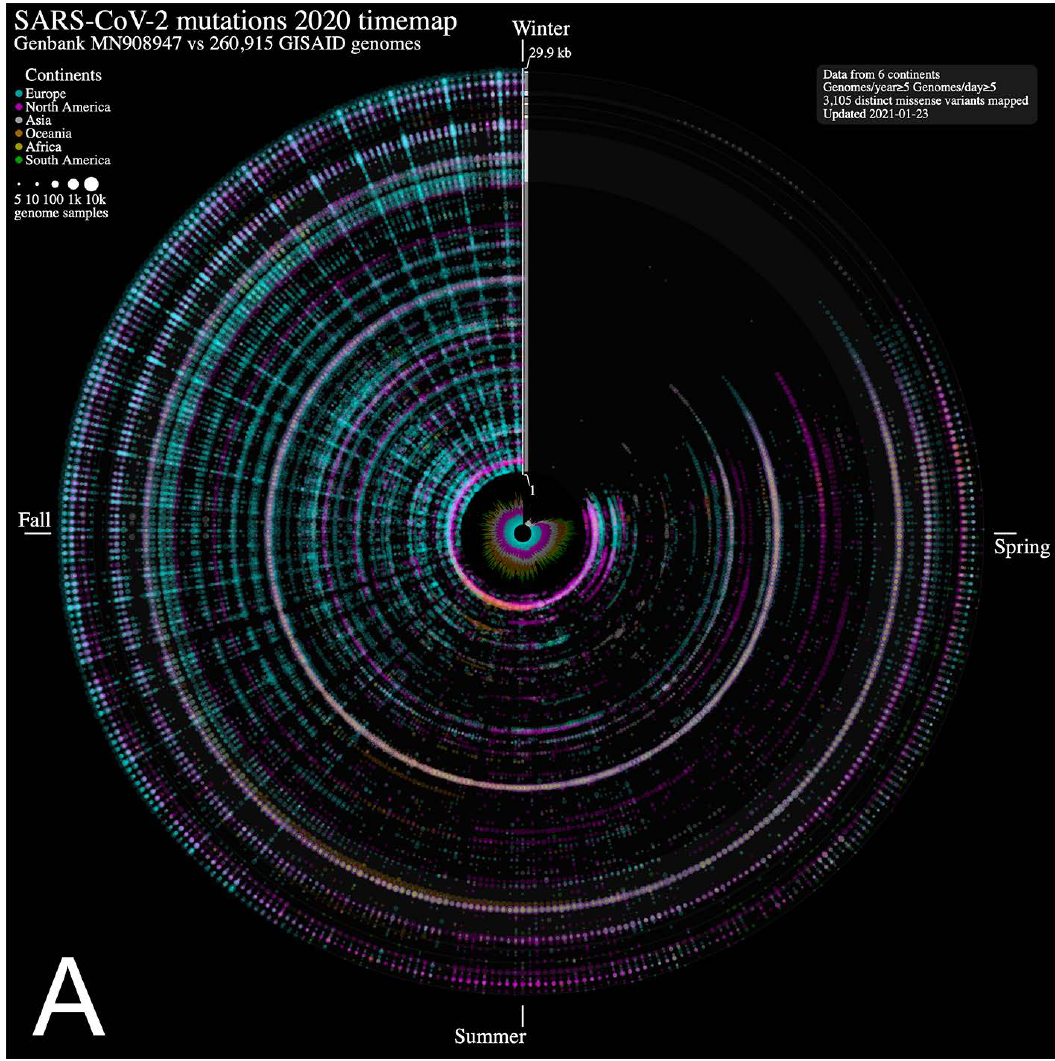
Figure 1. Severe acute respiratory syndrome coronavirus 2 (SARS-CoV-2) evolution in human hosts. ntEdit was used to map nucleotide variations between the first published coronavirus isolate from Wuhan, China in early Januaryandover260,000SARS-CoV-2genomessampledfromaroundtheglobeduringthe2020coronavirusdisease 2019 (COVID-19) pandemic. The maps show missense mutations arising daily (A) in the world within the whole viral genome, with the reference genome represented by the vertical axis from bases 1 to 29.9 kbp and (B) in Europe within the spike protein gene. Alternating dark / light grey vertical rectangles and associated tracks depict, starting from the center, SARS-CoV-2 genes ORF 1 AB , S, ORF3 A , E, M, ORF6, ORF7 A , ORF8, N, and ORF10. Mutations identified daily are represented by circles in a given radius and are coloured by regions and sized relative to raw count (panel A) or ratio (panel B) of the daily samples. A stacked bar plot (center) shows sample count. The 2020 calendar year mutations are organized clockwise from the upper vertical. Hovering the mouse cursor over each data point reveals additional insights about the mutation, and each map offers a navigation wheel allowing to pan inall direction and zoomin/out(panelB).PanelBshowsanannotatedtimemapofEurope,highlightingthedetectionofthefirstD614G spike protein gene mutation on January 28 th 2020 (Germany, n = 3, upper right). We also highlight the N501Y spike mutation first observed on September 20 th 2020 (panel B, inset) in only 1.7% (n = 2) of the Wales, UK daily genome samples, and at the end of the year on December 28 th 2020 in 15.5% (n = 13) of the daily collected Wales, UK samples (data updated on May 24 th , 2021). White arrows near the genome axis are used to draw attention to the emergence of spike protein gene mutations (from top to bottom) D1118H, S982A, T716I, P681H, A570D and